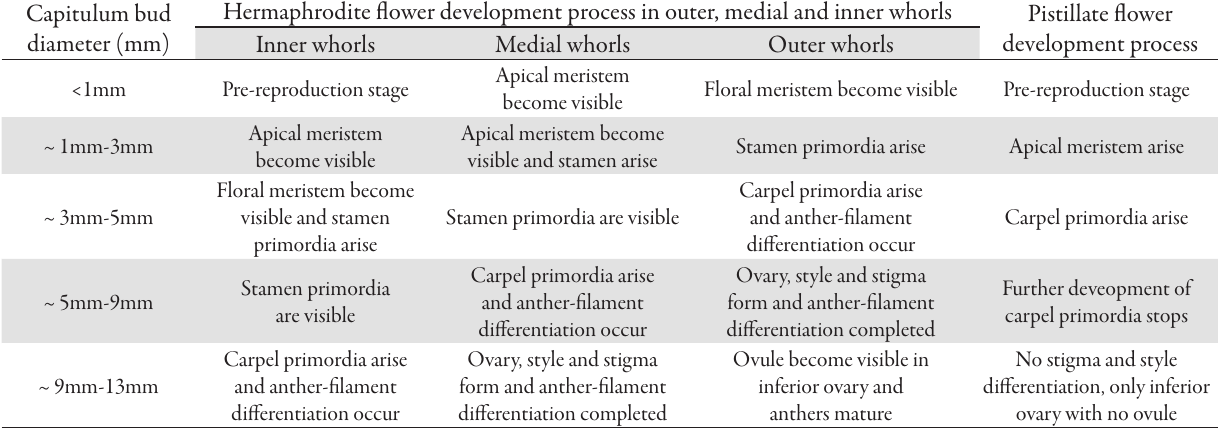
Tab. 1. Comparative developmental processes in the whorls of hermaphrodite and pistillate florets in respect of the diameter of capitulum bud in Helianthus annuus